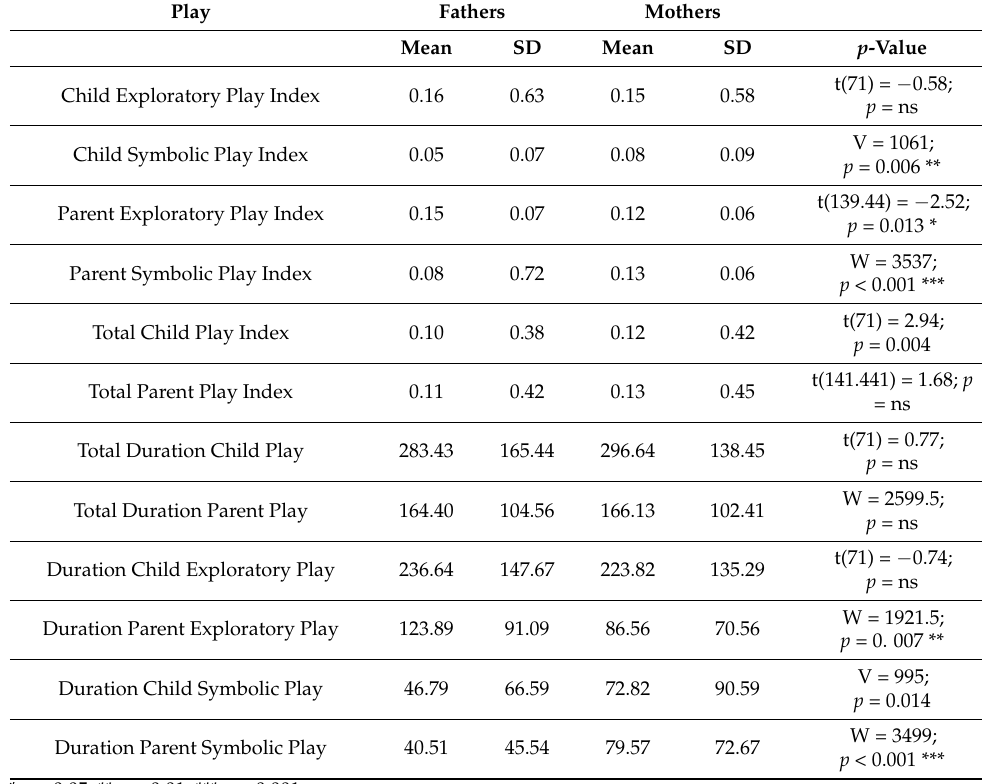
Table 2. Descriptive and Inferential Statistics of Paternal and Maternal